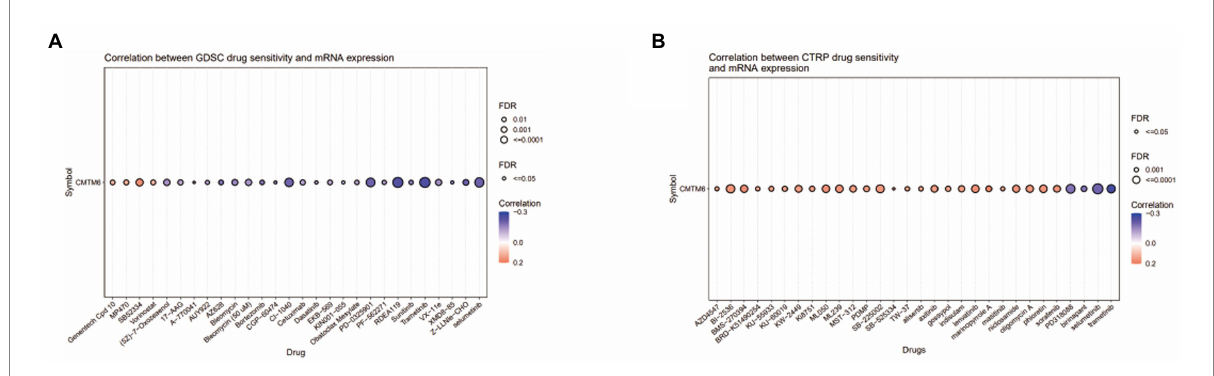
FIGURE 8 The relationship between CMTM6 and drug sensitivity in pan-cancer. (A&B) Bubble plots of top 30 drugs of genomics of drug sensitivity in cancer (GDSC) and cancer therapeutics response portal (CTRP) in relation to CMTM6 expression in pan-cancer